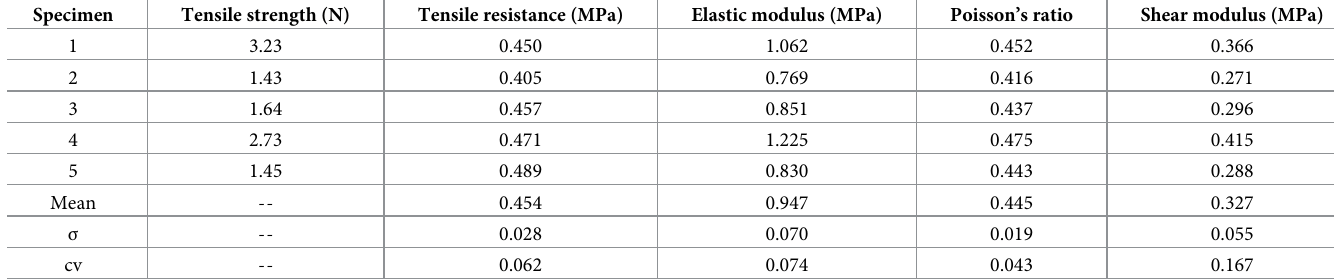
Table 8. Tensile mechanical test record of black fungus leaves. Specimen Tensile strength